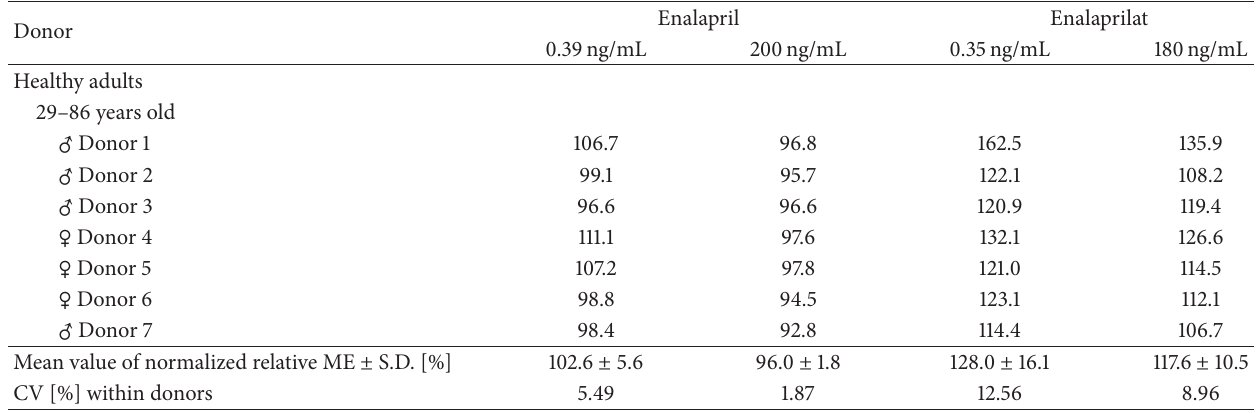
Table 2: Relative matrix effect obtained in seven different human